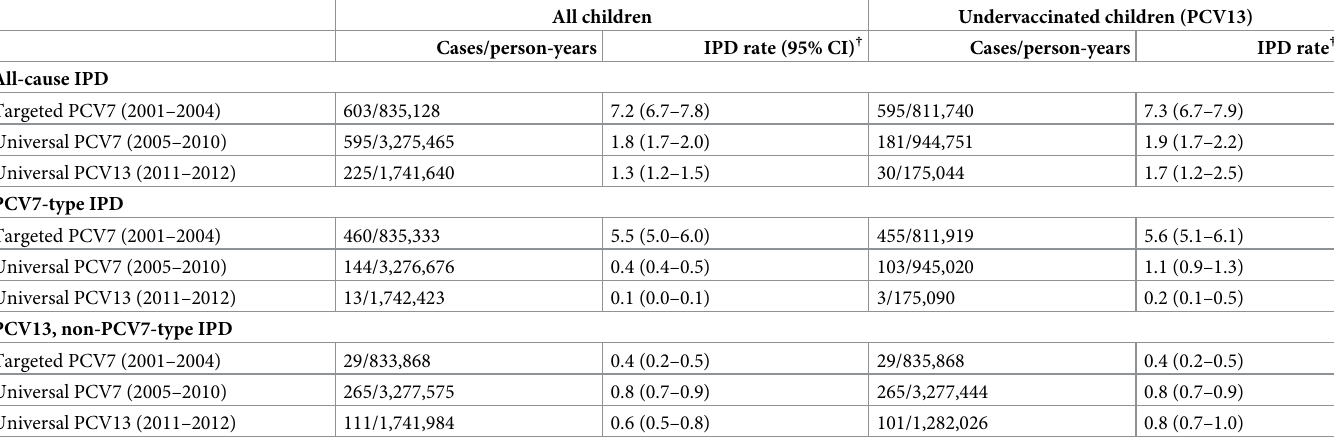
Table 2. Rates of IPD among all children and undervaccinated children � by vaccination period, New South Wales and Western Australia, 2001–2012.